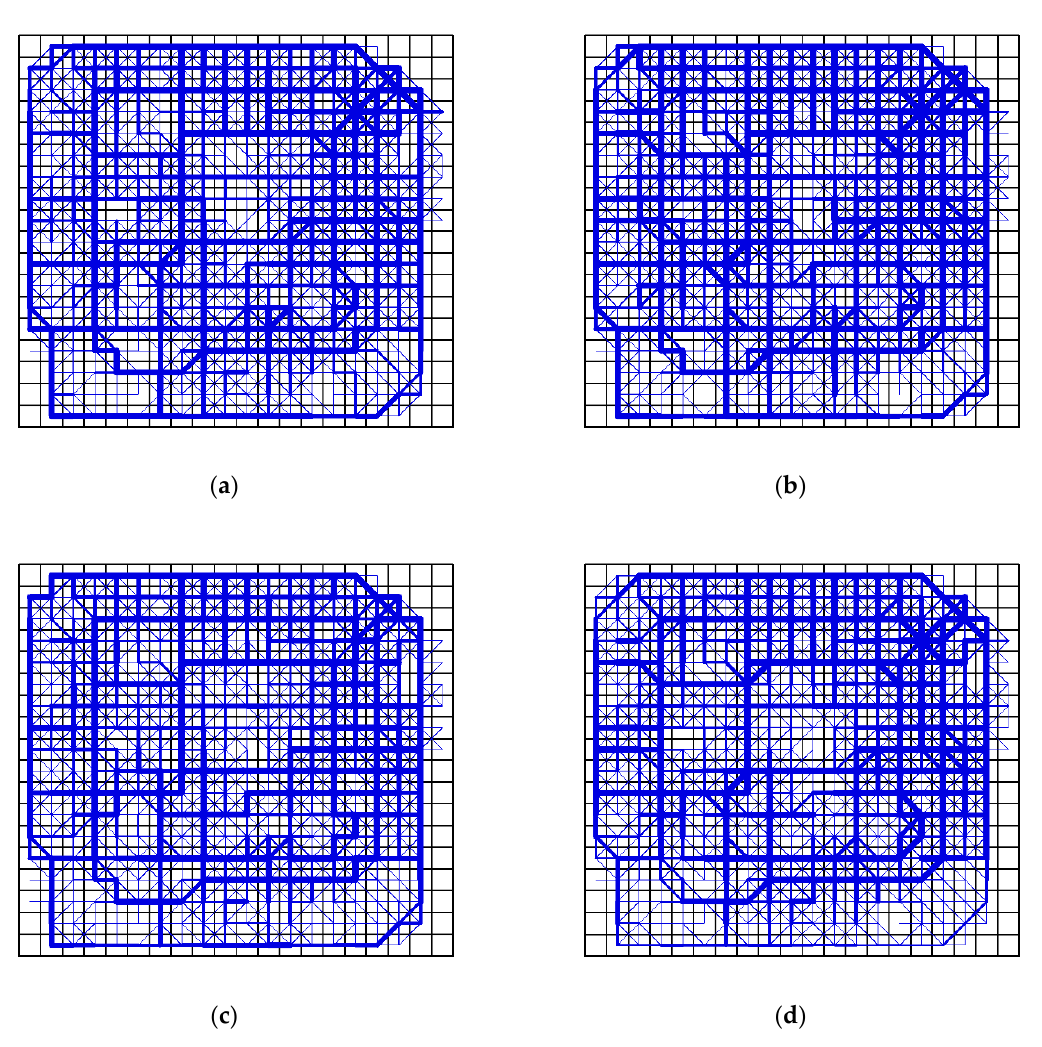
Figure 6. Spatially embedded networks for tra ffi c flows in di ff erent time periods with cell Figure 6 . Spatially embedded networks for traffic flows in different time periods with cell size k =